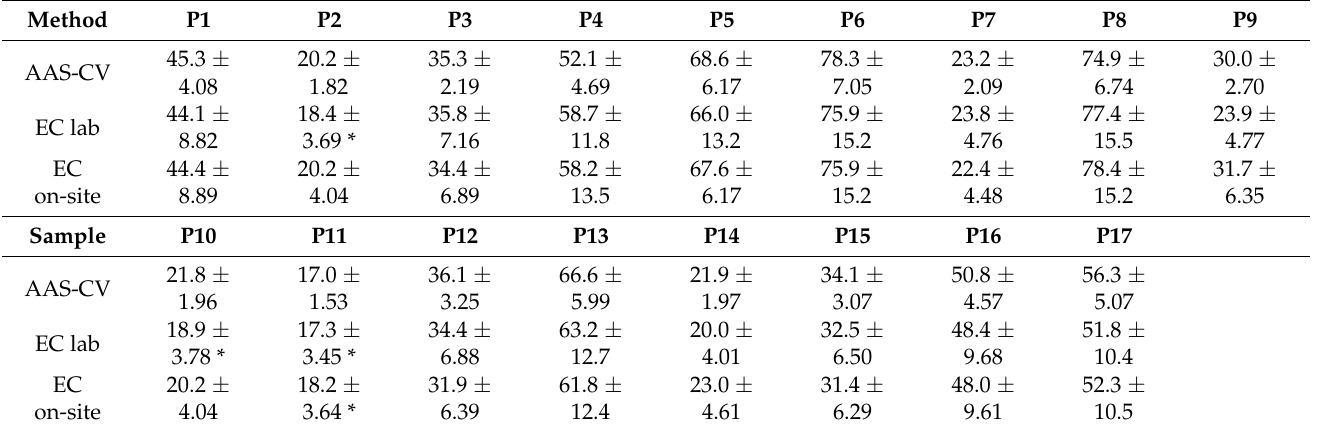
Table 10. Hg 2+ concentration in wastewater samples using the electrochemical procedure with SPE-poly L modified electrodes and